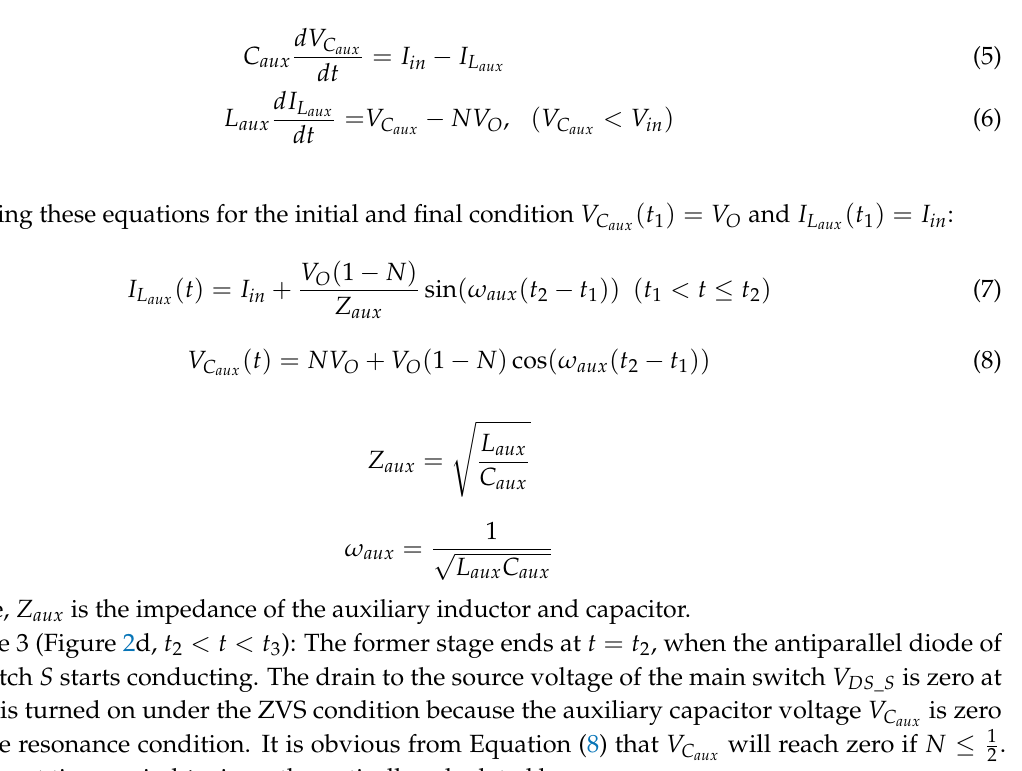
> 0. If the aux continues to decrease to zero. The aux